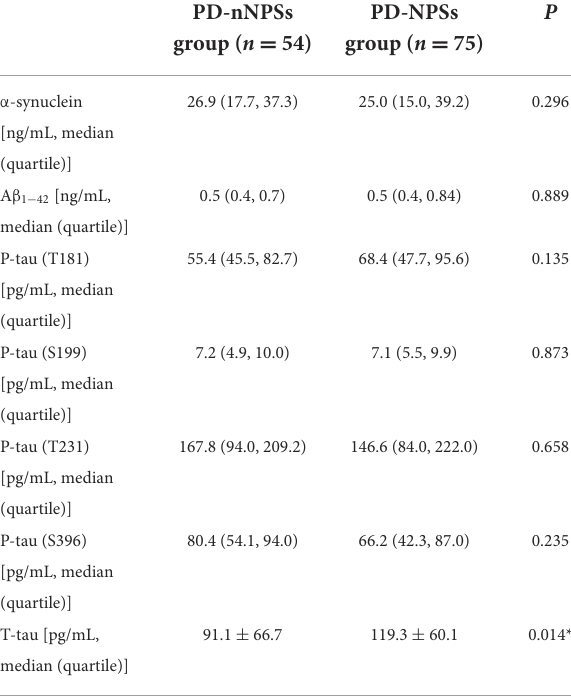
TABLE 5 Comparisons of the levels of neuropathological proteins in CSF between PD-NPSs and PD-nNPSs